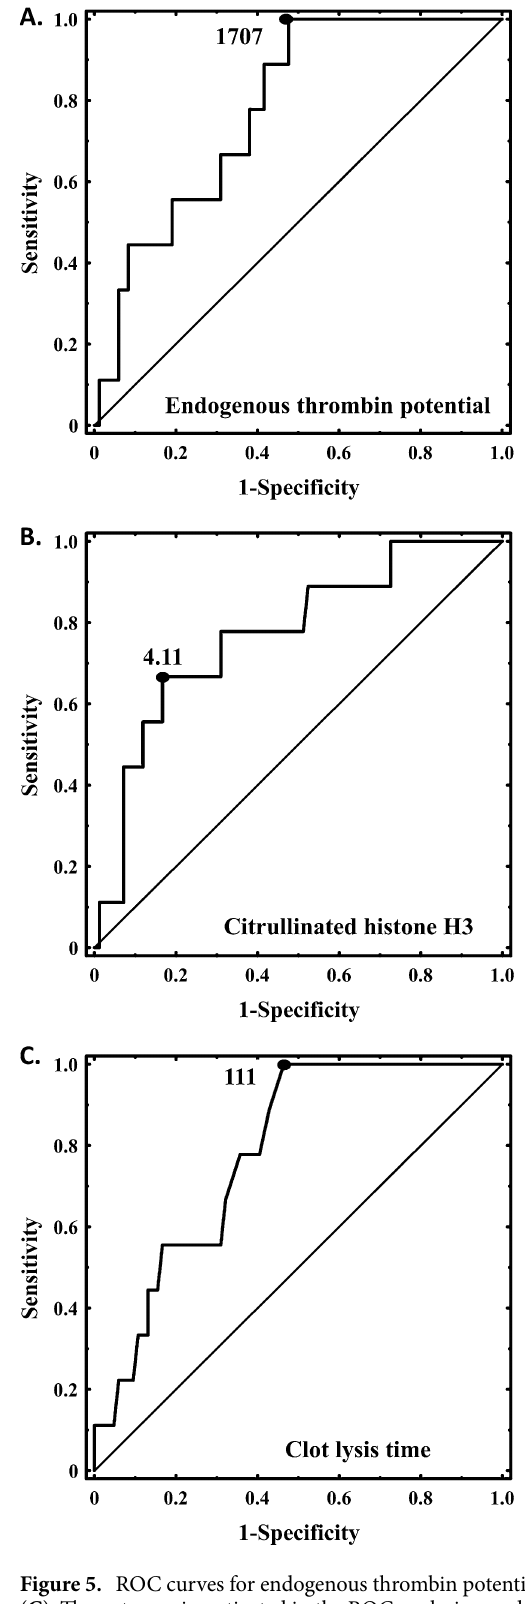
Figure 5. ROC curves for endogenous thrombin potential ( A ), citrullinated histone H3 ( B ), and clot lysis time ( C ). The outcome investigated in the ROC analysis was death during 1-year follow-up. Optimal cutoffs are